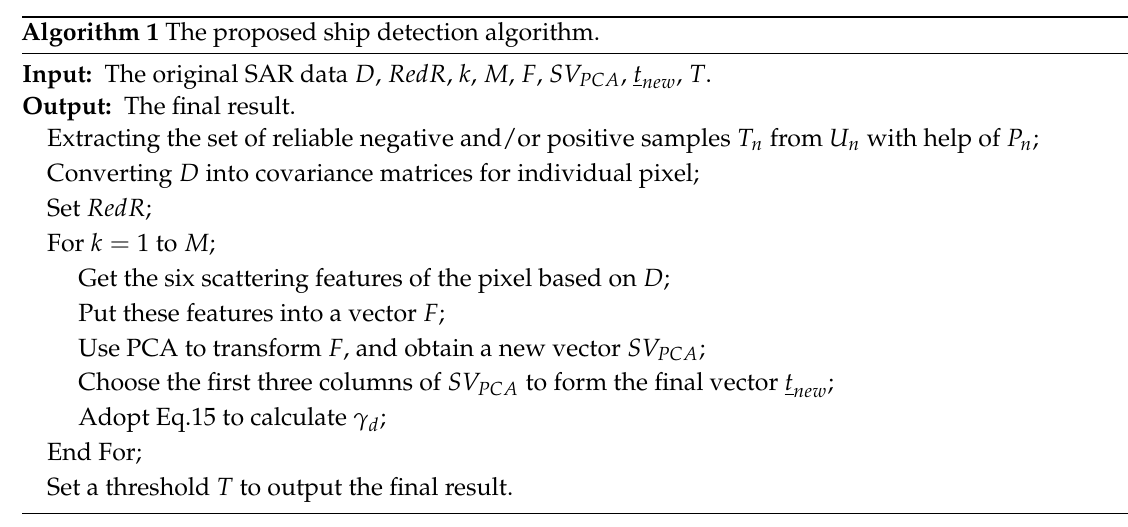
Algorithm 1 The proposed ship detection